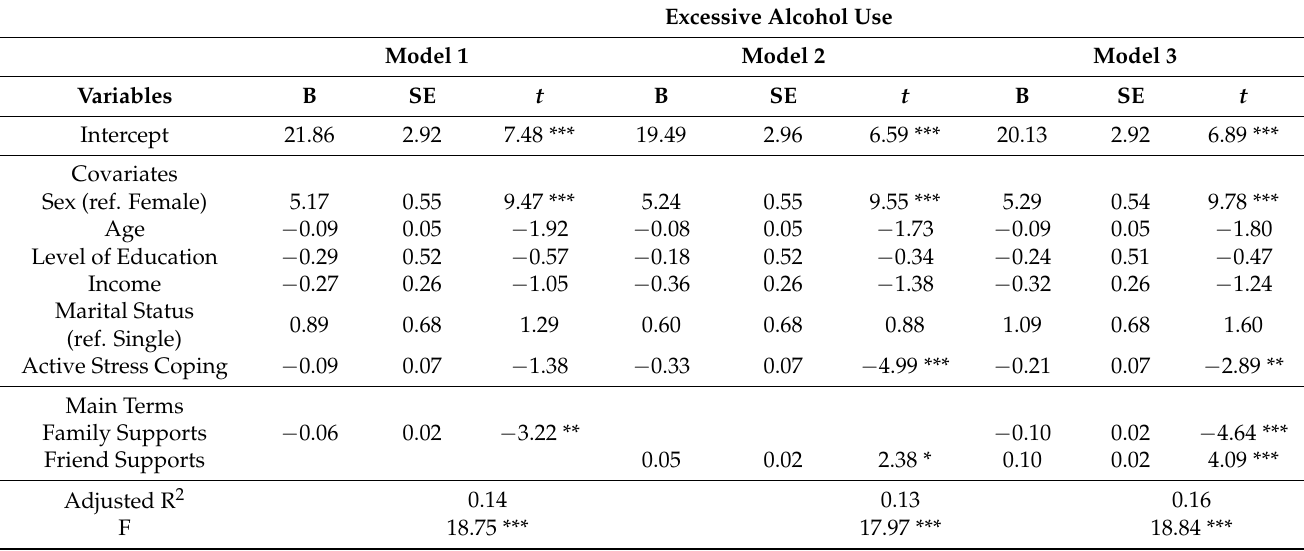
Table 2. The results of OLS regressions on excessive alcohol use (n =